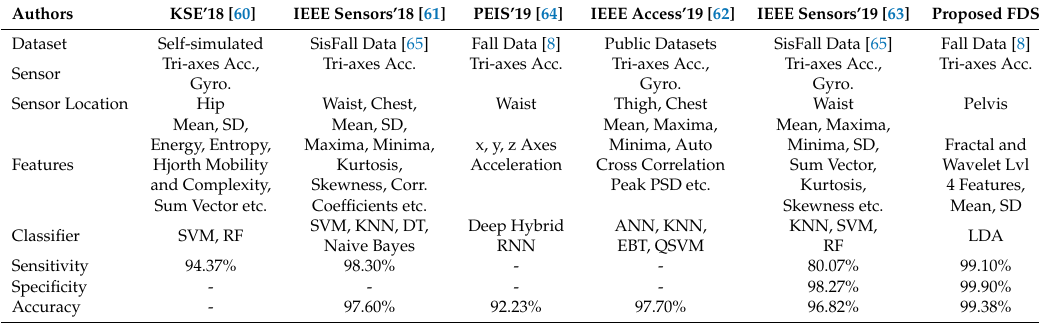
Table 4. Classification Performance